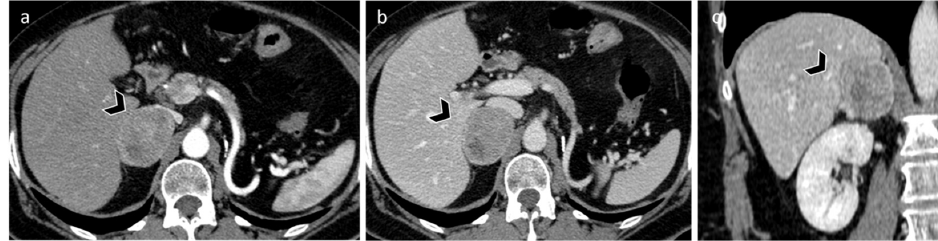
Figure 5. A 65-year-old female with right adrenal pheochromocytoma. CT axial arterial ( a ) and portal venous phases ( b , c ) show inhomogeneous adrenal solid lesion with strong and heterogeneous enhancement; the lesion showed an absolute wash-out of